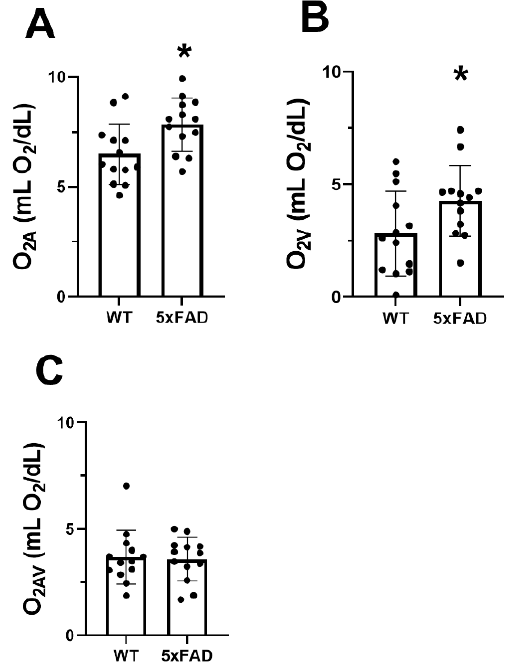
Figure 3. Vascular oxygen contents in wild-type (WT) and five-familial Alzheimer’s disease (5XFAD) mice. ( A ) Retinal arterial oxygen content (O 2A ), ( B ) venous oxygen content (O 2V ), and ( C ) arteriovenous oxygen content difference (O 2AV ) in WT and 5XFAD groups. The data are presented as mean ± SD. * p < 0.05.